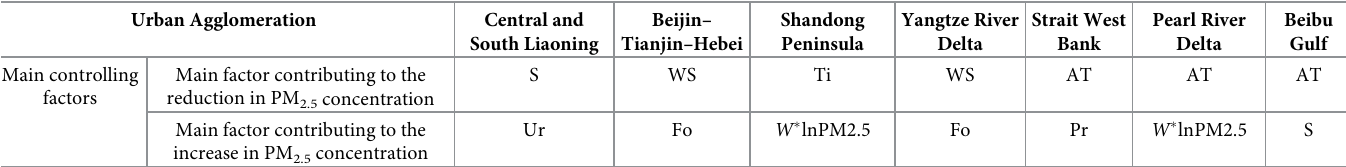
Table 6. Analysis of the main factors controlling PM 2.5 pollution in China’s coastal urban agglomerations. Urban